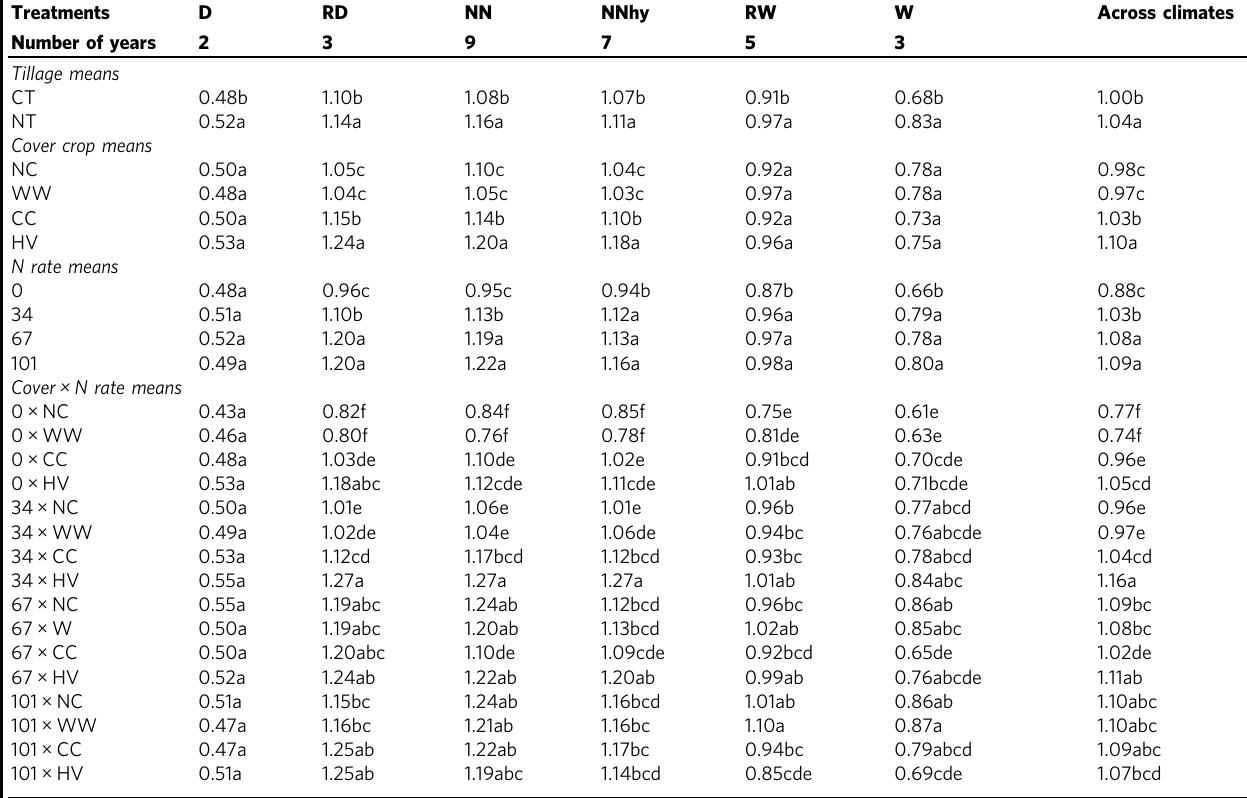
Table 1 Means for cotton yield (Mg ha − 1 ) under tillage, cover crop, N rate (nitrogen rate), and N rate × cover crop interaction in dry (D), relatively dry (RD), near-normal (NN), high-yielding near-normal (NNhy), relatively wet (RW), and wet (W) years and across all climate